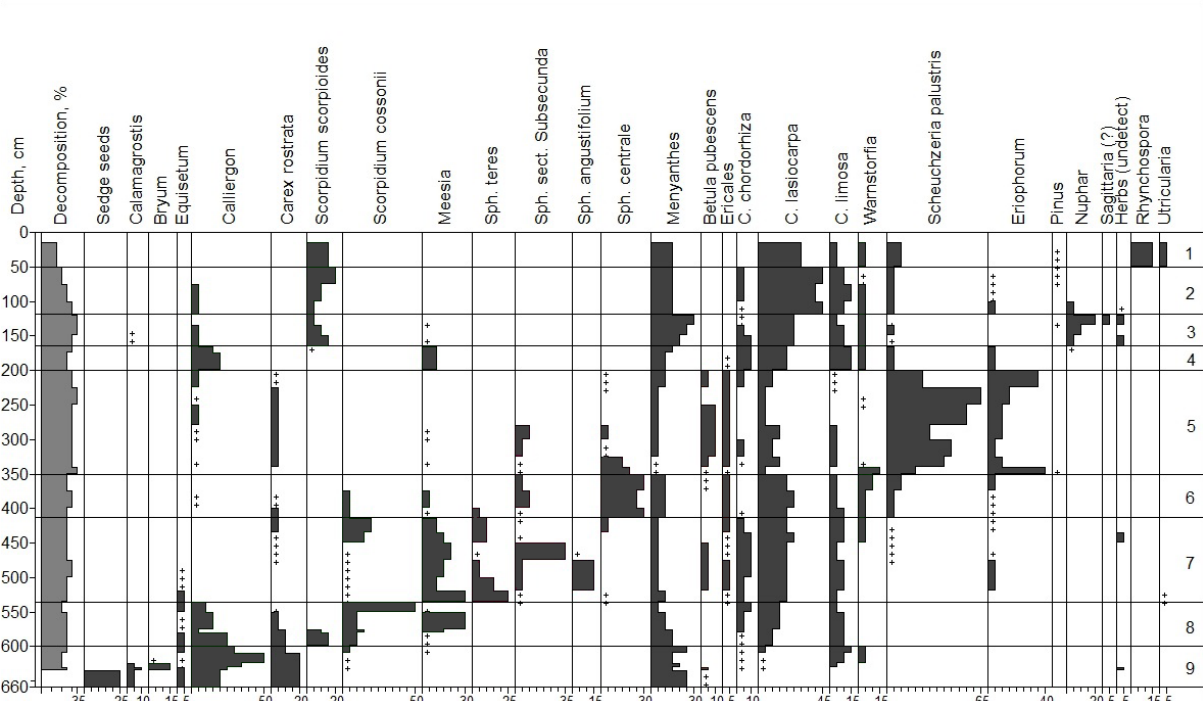
Figure 4. Peat macrofossil diagram for Sample Plot 4 (flark). Palaeocommunities: 1) Carex lasiocarpa + Rhynchospora alba - Scorpidium scorpioides ; 2) Carex lasiocarpa - Scorpidium scorpioides ; 3) Carex lasiocarpa + Menyanthes trifoliata + Nuphar ; 4) Carex spp. - Calliergon + Meesia ; 5) Scheuchzeria palustris + Eriophorum , 6) Carex lasiocarpa - Sphagnum centrale ; 7) Carex spp. - Sphagnum spp. + Bryales, 8) Carex spp. - Bryales; 9) Carex rostrata + Menyanthes trifoliata - Calliergon